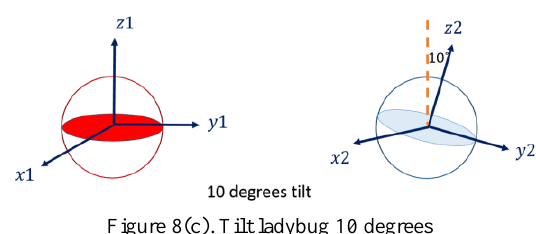
Figure 8(c). Tilt ladybug 10 degrees